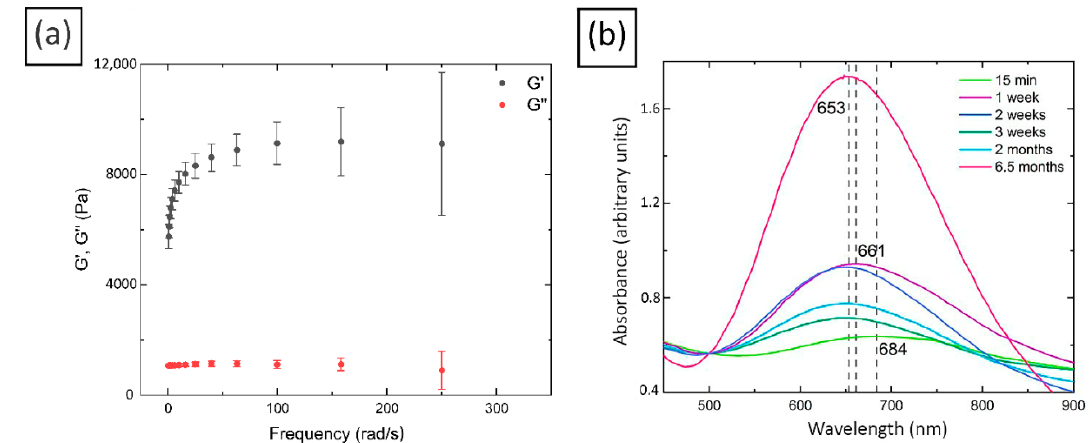
Figure 2. ( a ) Rheological study of freshly prepared Cu/CS composites (low molecular weight chitosan, molar ratio Cu/CS = 1/5); ( b ) UV-visible spectra of Cu/CS composites (low molecular weight chitosan, molar ratio Cu/CS = 1/10).